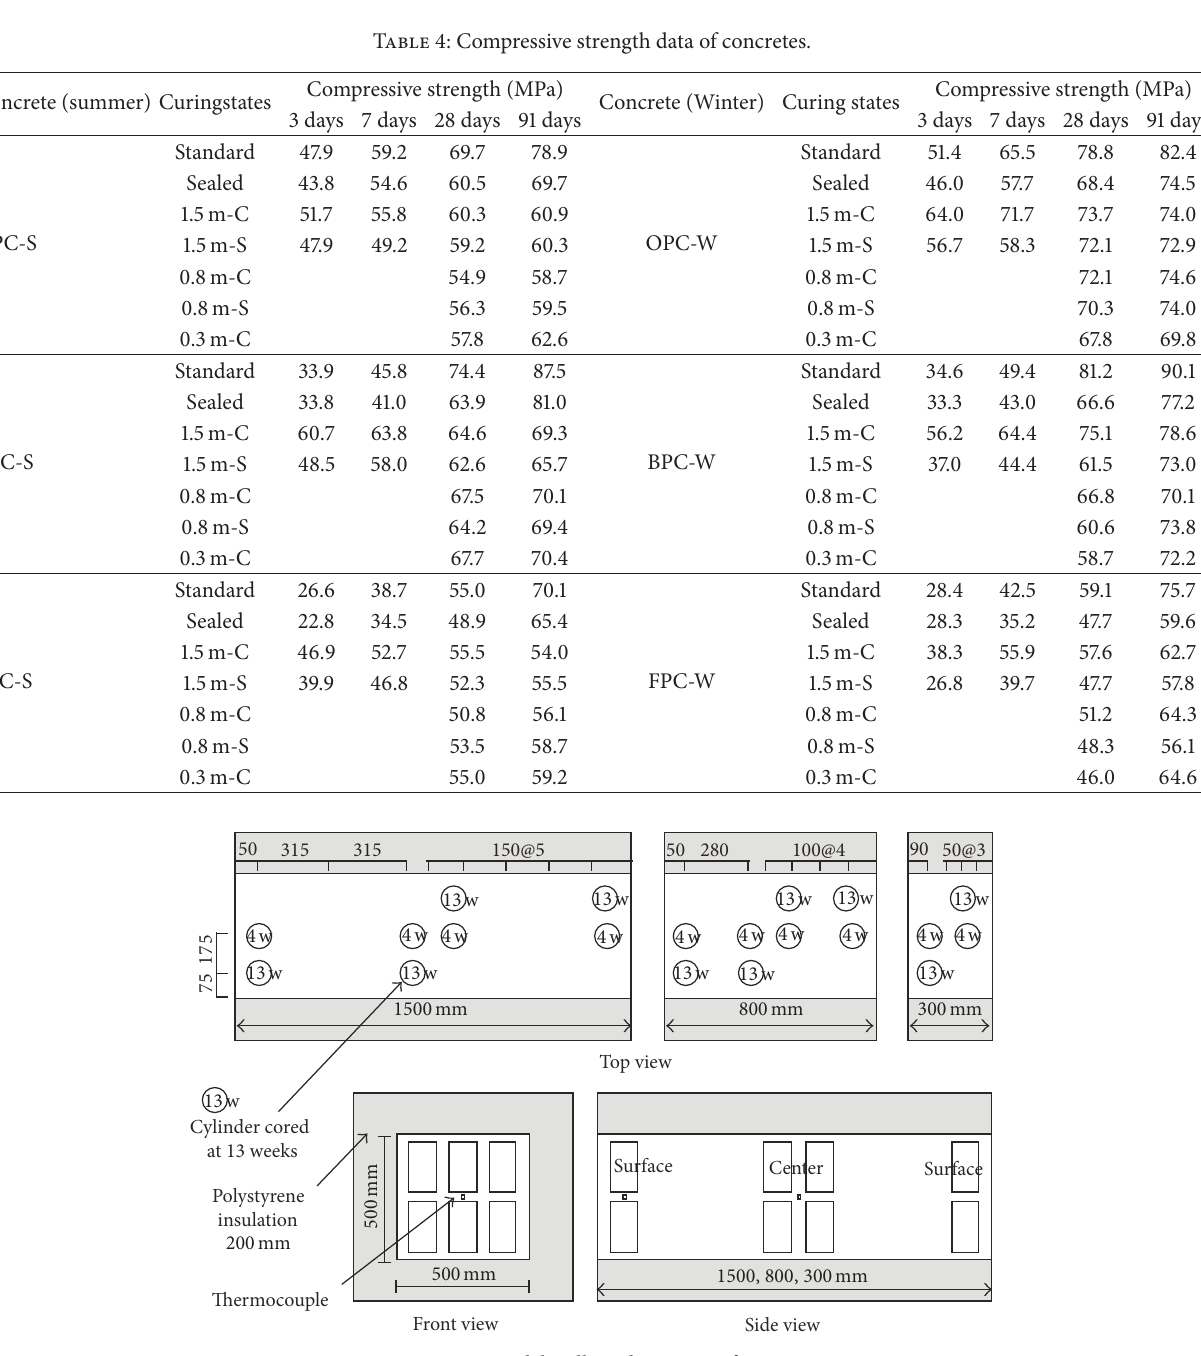
Figure 1: Model walls and position of